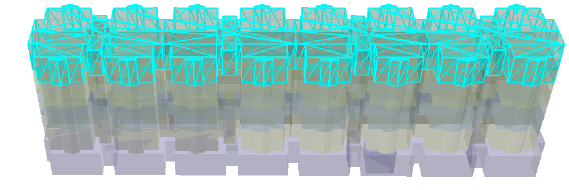
Figure 19. Query using floor